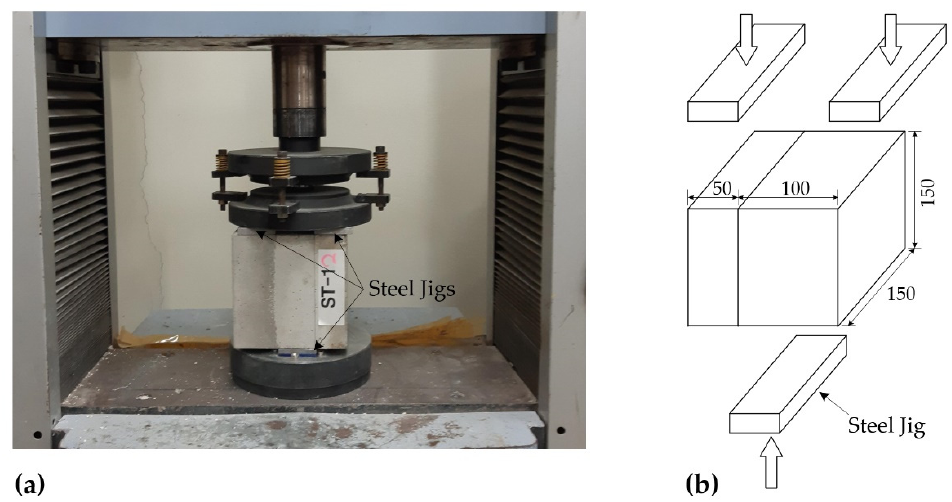
Figure 3. ( a ) Set-up for bi-surface direct shear test; ( b ) loading scheme with steel jigs (unit: mm). The bond strength ( σ ) of the specimens is calculated by [26] P σ = (1) A where P = maximum load at failure (N), and A = area of the bond plane (mm 2 ). Figure 4 shows the bond strength for all sets of the specimens, and average values of the test results are summarized in Table 5.